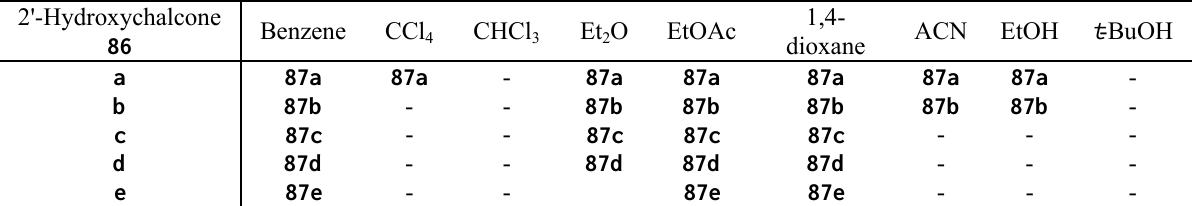
Table 7. Solvent effects on the photocyclization of 2'-hydroxychalcones to flavanones.